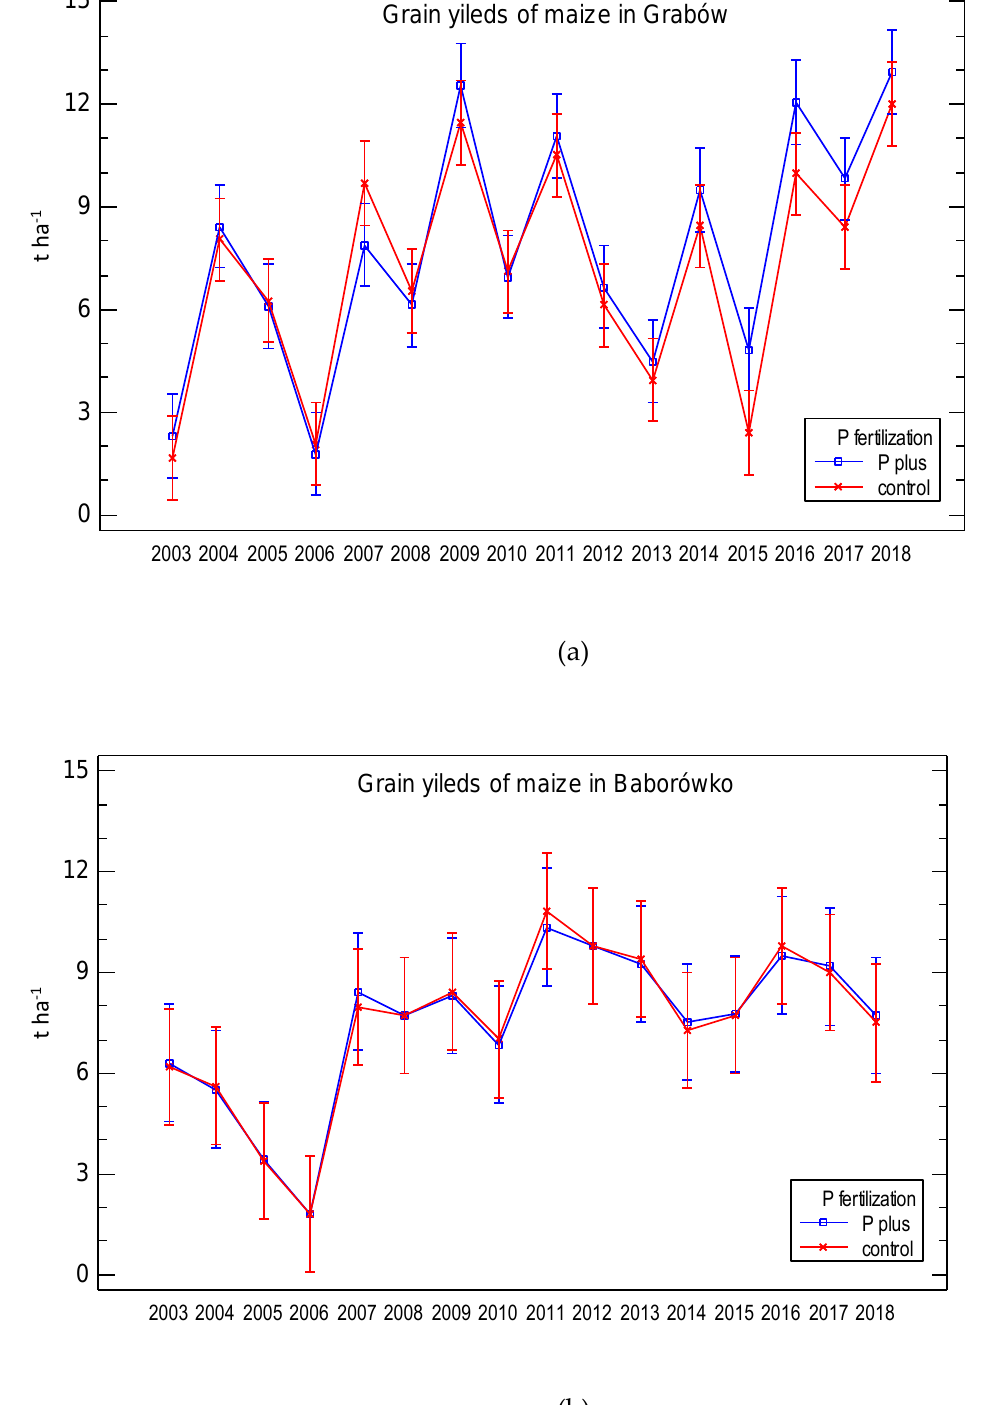
Figure 3. Grain yields of maize in (a) Grabów and (b) Baborówko; 95% Tukey HSD intervals; n = 384 for each location.